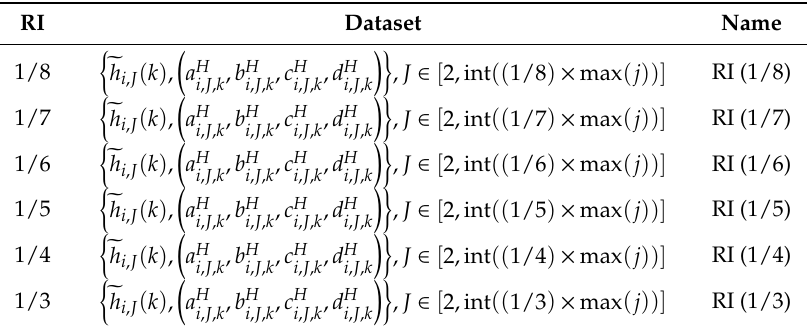
Table 4. Recording process details.